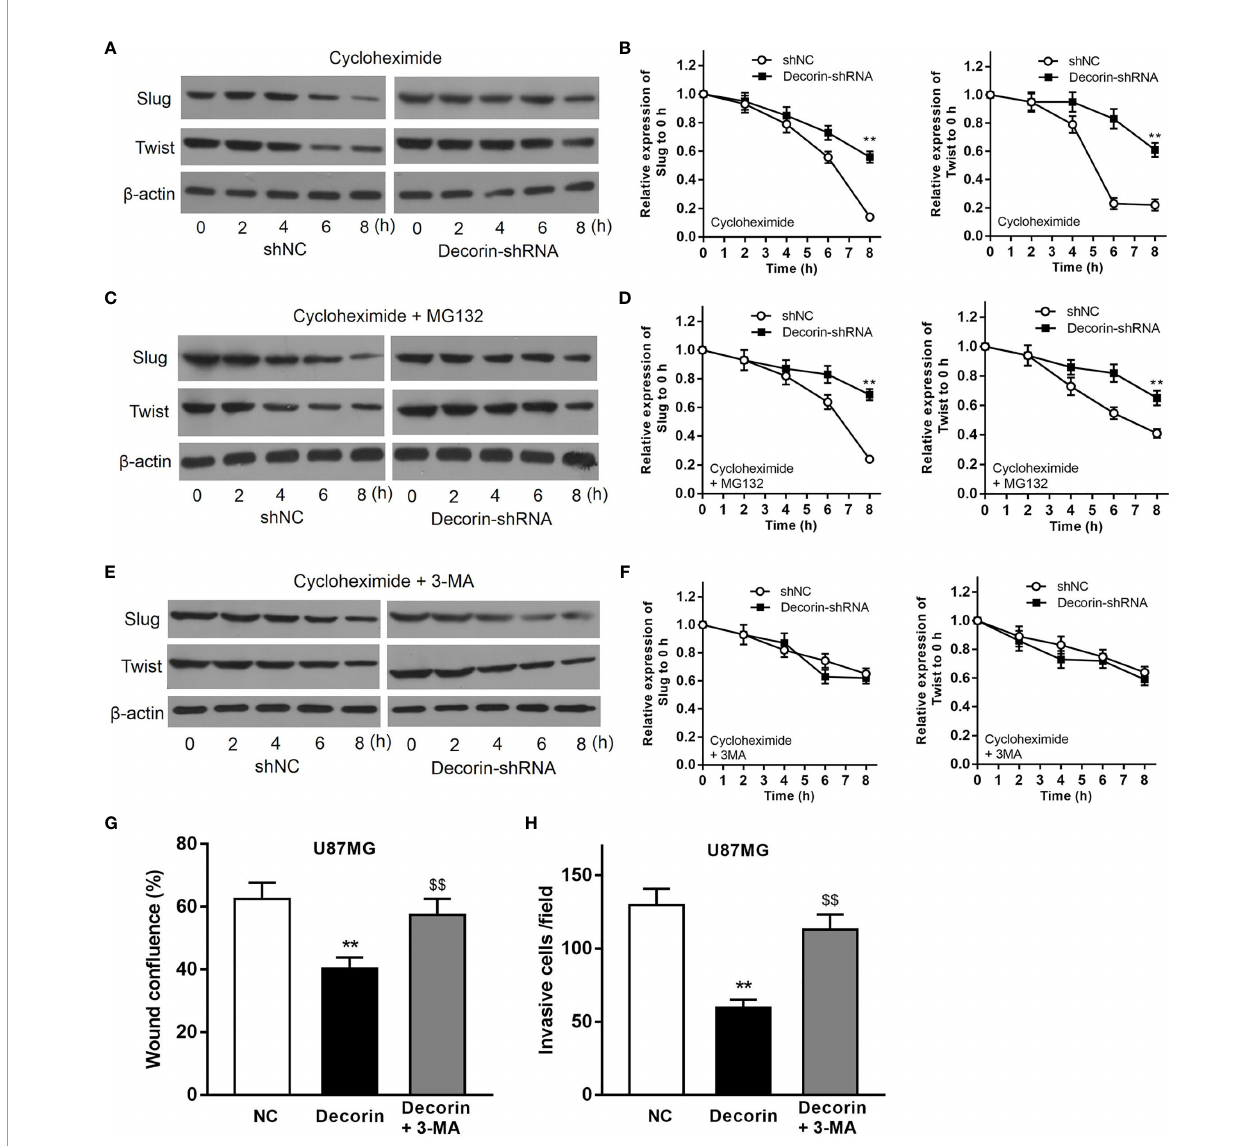
FIGURE 4 | Decorin inhibits EMT phenotype through the induction of autophagy in glioma cell lines. (A) T98G cells were infected with LV-decorin-shRNA vector. Cells were treated with 100 m g/mL of cycloheximide. Western blot results showed that the degradation of Slug and Twist in T98G-shNC cells were much rapid than that in T98G-decorin-shRNA cells. (B) Measurement data of (A) (means ± S.D. @ of 3 independent experiments). **P<0.01 vs . shNC. (C) Treatment of the cells with both cycloheximide and 10 m M of MG132 could not change these effects between groups. (D) Measurement data of (C) (means ± S.D. @ of 3 independent experiments). **P < 0.01 vs. shNC. (E) The degradation rates of Slug and Twist were similar between T98G-shNC and T98G-decorin-shRNA cells after the cells were treated with cycloheximide and 10 mmol/L 3-MA. (F) Measurement data of (E) (means ± S.D. @ of 3 independent experiments). (G, H) 3-MA treatment could block the effects of decorin overexpression-induced inhibition of migration and invasion of U87MG cells. (means ± S.D. @ of 3 independent experiments).). **P < 0.01 vs. NC; $$ P < 0.01 vs.